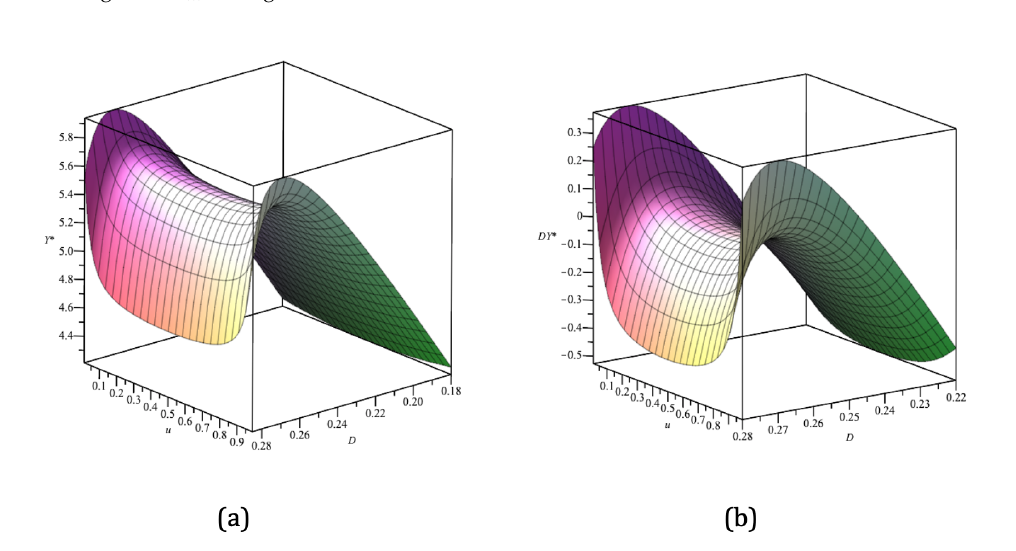
Figure 8. ( a ) Yield Y ∗ ( u , D ) at equilibrium for the system of coupled chemostats with respect to u and D . ( b ) Excess Yield ∆ Y ∗ ( u , D ) at equilibrium for the system of coupled chemostats with respect to u and D . Parameters set: µ = 0.3 h − 1 , k = 0.2 g · L − 1 and s in = 12 g · L − 1